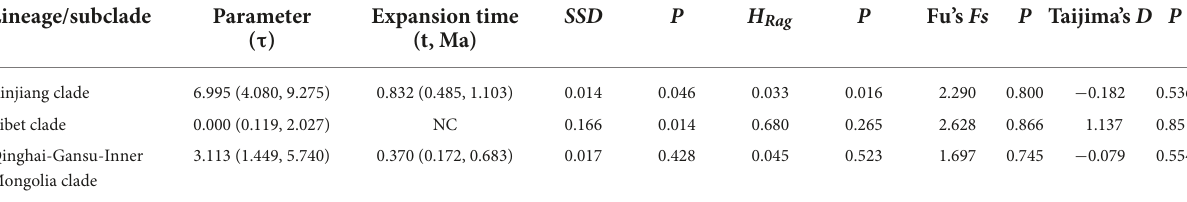
TABLE 3 Results of mismatch distribution analysis (MDA) and neutrality tests for pooled populations of clades of Scrophularia incisa complex. Lineage/subclade